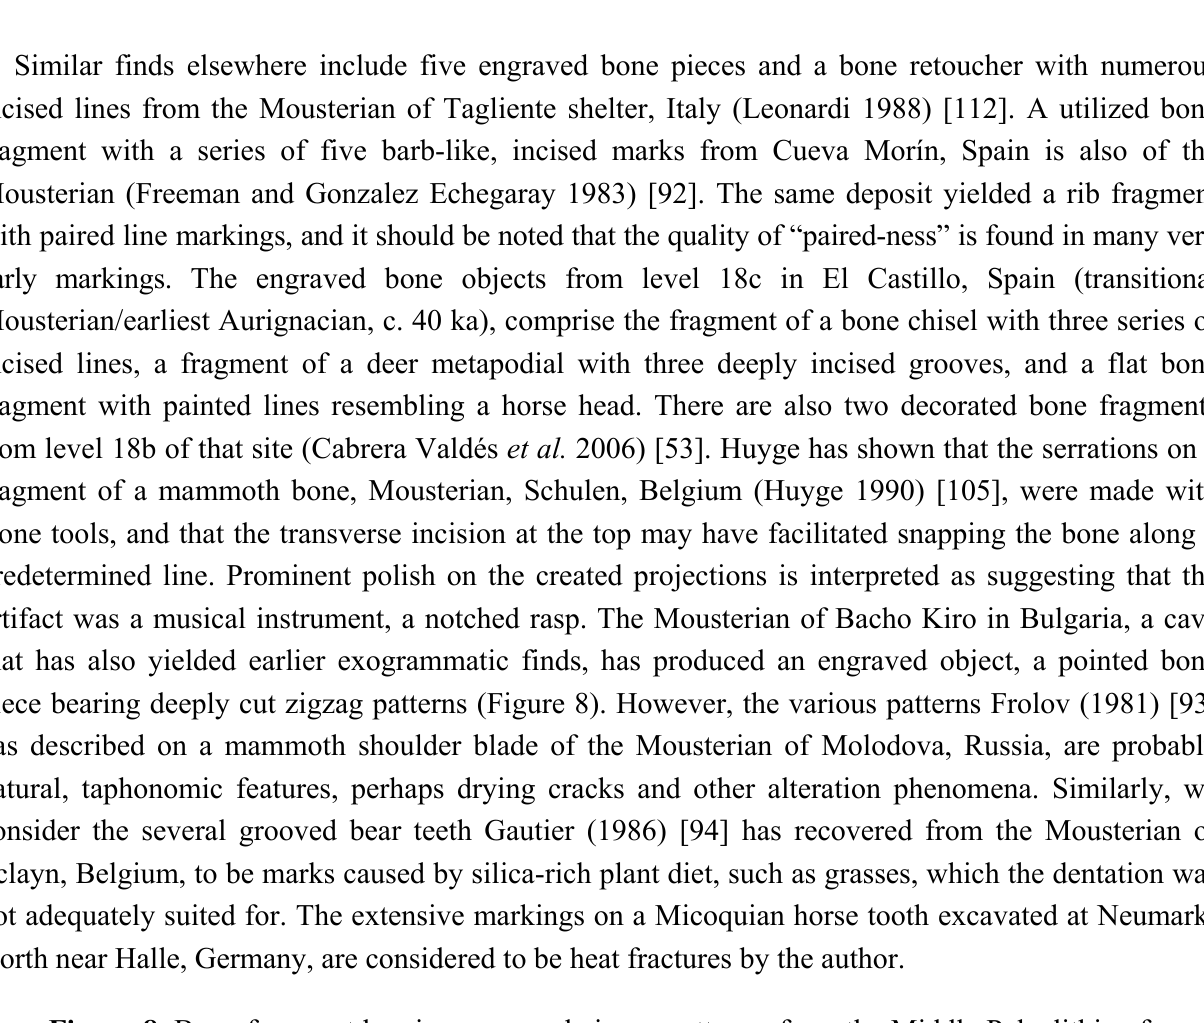
Figure 8. Bone fragment bearing engraved zigzag patterns, from the Middle Paleolithic of the vast cave Bacho Kiro near Dryanovo in central